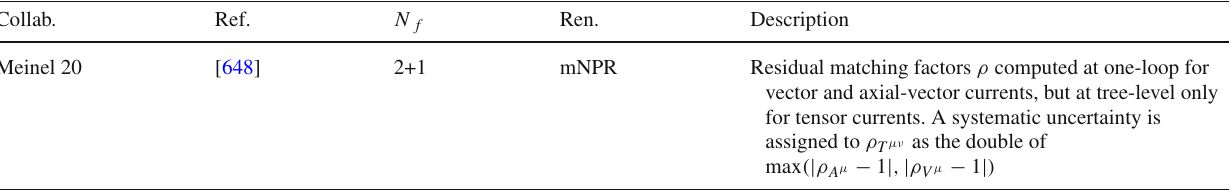
Table 163 Operator renormalization in determinations of form factors for rare decays of beauty hadrons Collab.